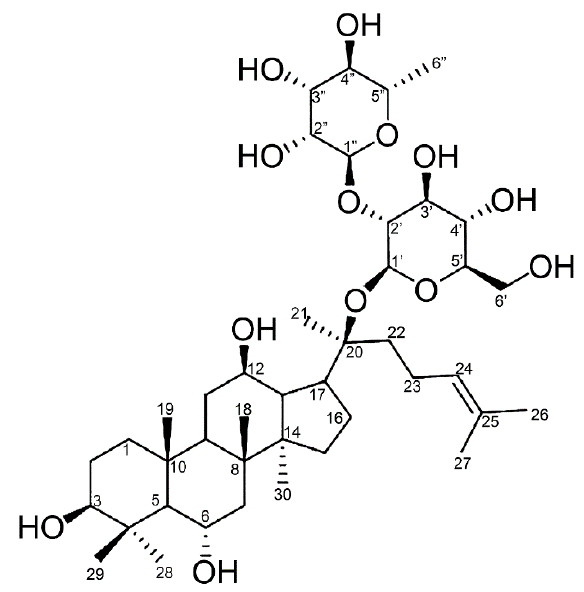
Figure 5. The structure ginsenoside MT1 based on the spectral data.